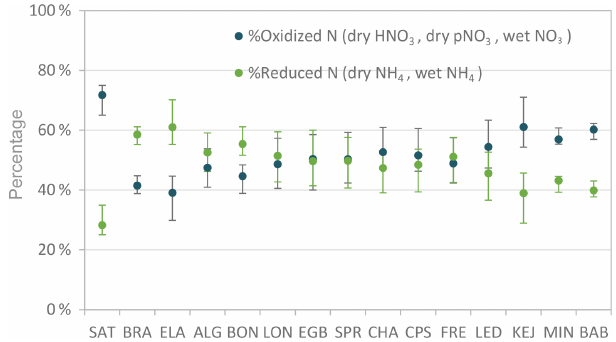
Figure 6. Percentage of oxidized and reduced N species in annual total deposition of N at CAPMoN sites during 2000–2018. Mean (circle); range or annual variability (error bars). Sites are listed in order longitudinally from west (left) to east